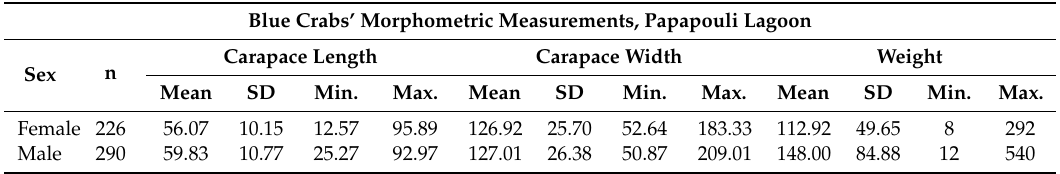
Table 2. Mean and Standard Deviation of CL, CW and W regarding blue crab measurements.